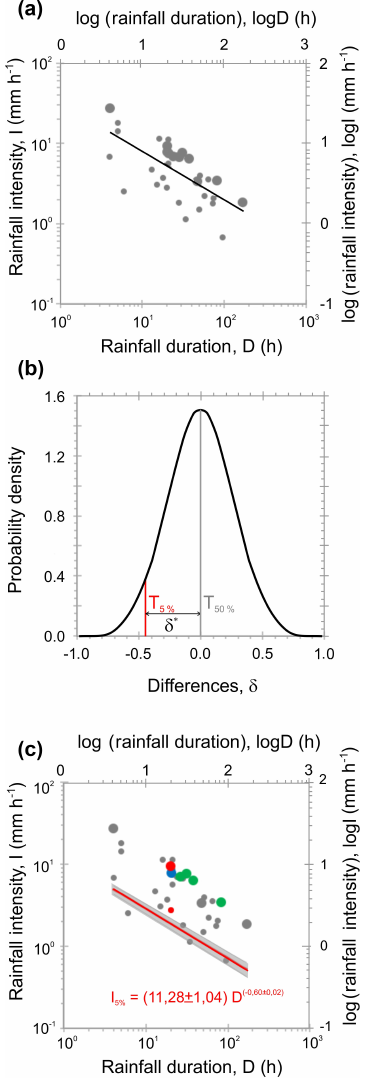
Figure 7. (a) Rainfall conditions ( D , I ) (dots) that have resulted in shallow landslides and earth flows in the Entella River basin, in the 15-year period 2002–2016 (Table 1). The black line represents the power law best-fit curve to the empirical rainfall ( D , I ) conditions. Small dots show single landslides and large dots show multiple landslides. (b) Graphic representation of the threshold correspond- ing to the 5% exceedance probability for the distribution of the em- pirical data points ( D , I ). Black line is the Gaussian model fit of the difference, for the distribution of the empirical data points ( D , I ). Gray vertical line corresponds to the 50% threshold (mean value). Red vertical line corresponds to the 5% threshold. (c) Red line rep- resents the 5% rainfall threshold for the Entella catchment. Colored dots show rainfall conditions for the 10–11 November 2014 rainfall event (green), the 21–22 October 2013 rainfall event (red), and the 23–24 November 2002 rainfall event (blue). Small dots show single landslides and large dots show multiple landslides. The surrounding gray area shows uncertainty of the